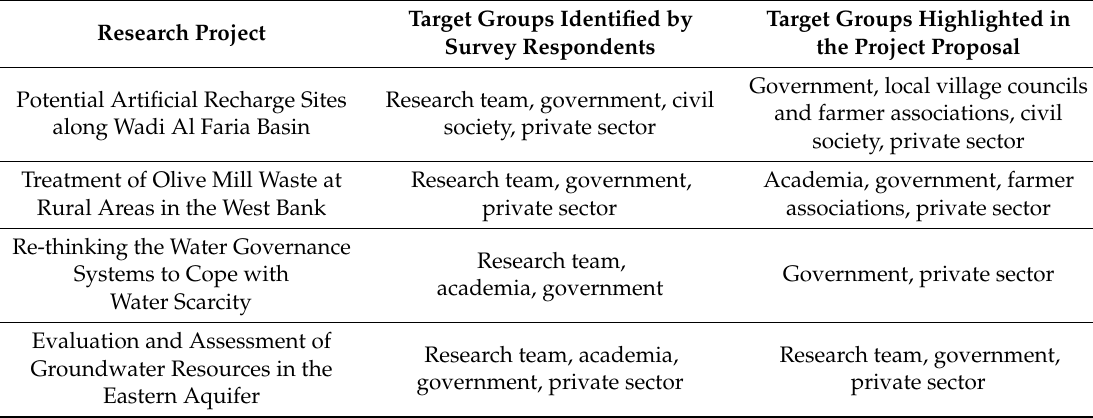
Table 7. Target groups that were identified by survey respondents and highlighted in the project